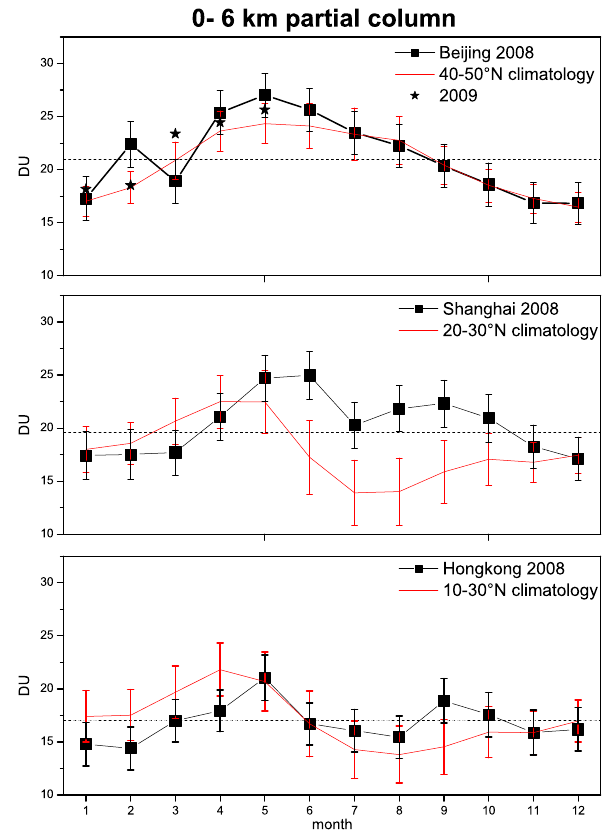
Fig. 7. Monthly variations of the mean 0–6km ozone columns mea- sured with IASI in 2008 over Beijing (top), Shanghai (middle), and Hong Kong (bottom), in Dobson Unit (DU). The mean columns are compared to the climatological column values (McPeters et al., 2007) for the latitudes bands that mostly influence each domain (red). The climatological variability is plotted as error bars for the climatological columns. The black stars in the top panel corre- spond to the monthly mean columns observed in 2009 over Beijing. The errors on the IASI observations are estimated for individual columns and for the typical conditions of each